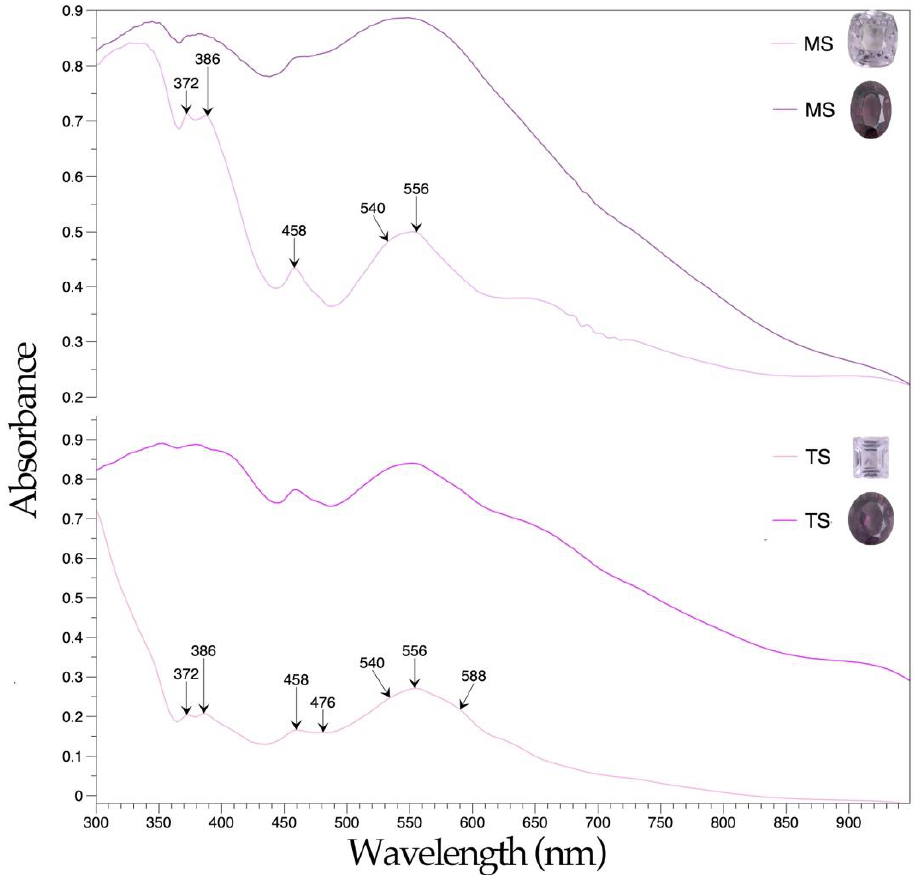
Figure 12. The representative UV-Vis-NIR absorption spectra of spinel samples TS and MS show absorption peaks related to Fe 2+ , Fe 3+ , Cr 3+ , and V 3+ .